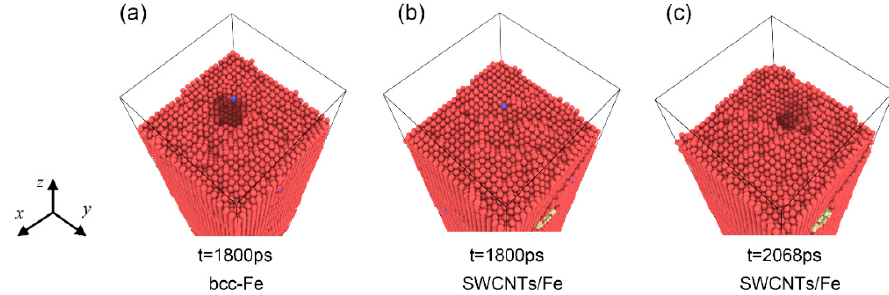
Figure 3. Surface topography of the matrix under irradiation. ( a ) He bubble burst from the Fe matrix, t = 1800 ps; ( b ) the surface topography of SWCNT/Fe composite, t = 1800 ps; ( c ) He bubble burst from the SWCNT/Fe composite, t = 2068 ps.